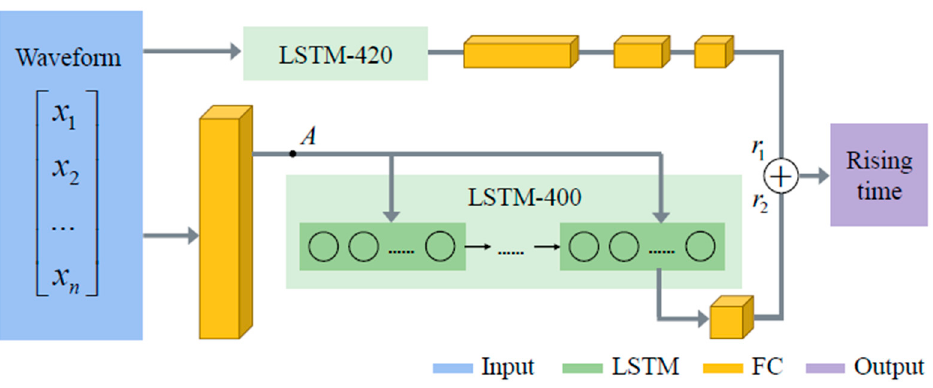
Figure 14. The structure of the combined long short-term memory network (ComLSTM) network. Reproduced with permission from Wang et al., Journal of Instrumentation; published by IOP Publishing for Sissa Medialab, 2020 [97].